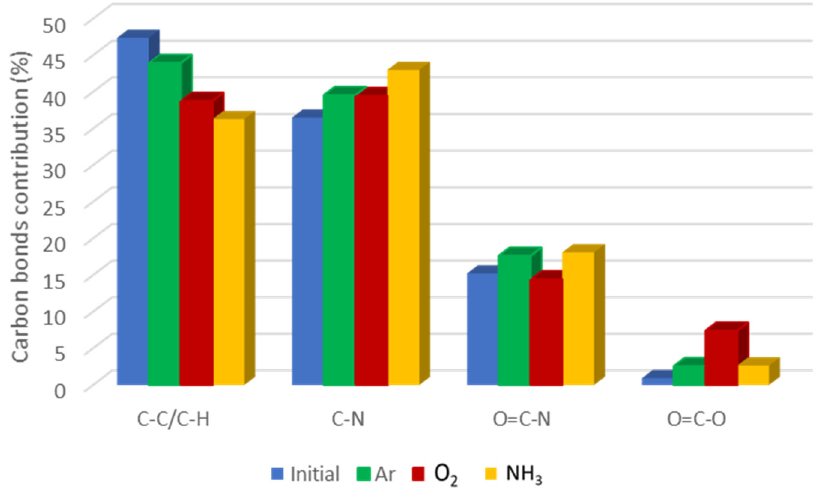
Figure 6. Comparative carbon bonds contribution in the pNIPAAM layers depending on plasma treatment working gas.